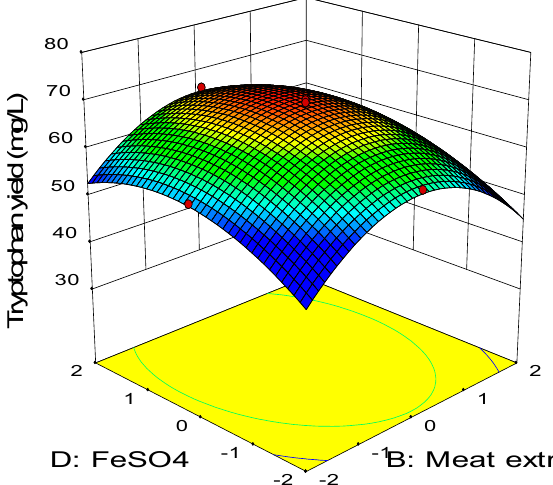
Figure 7. Response surface of tryptophan production by P. acidilactici TP-6 as a function of meat extract and FeSO 4.